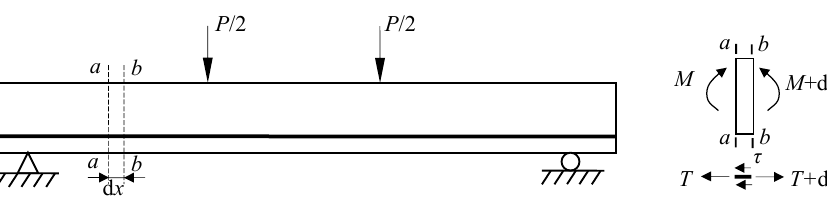
Figure 12. Force on the infinitesimal segment in the shear-bending zone and textile.